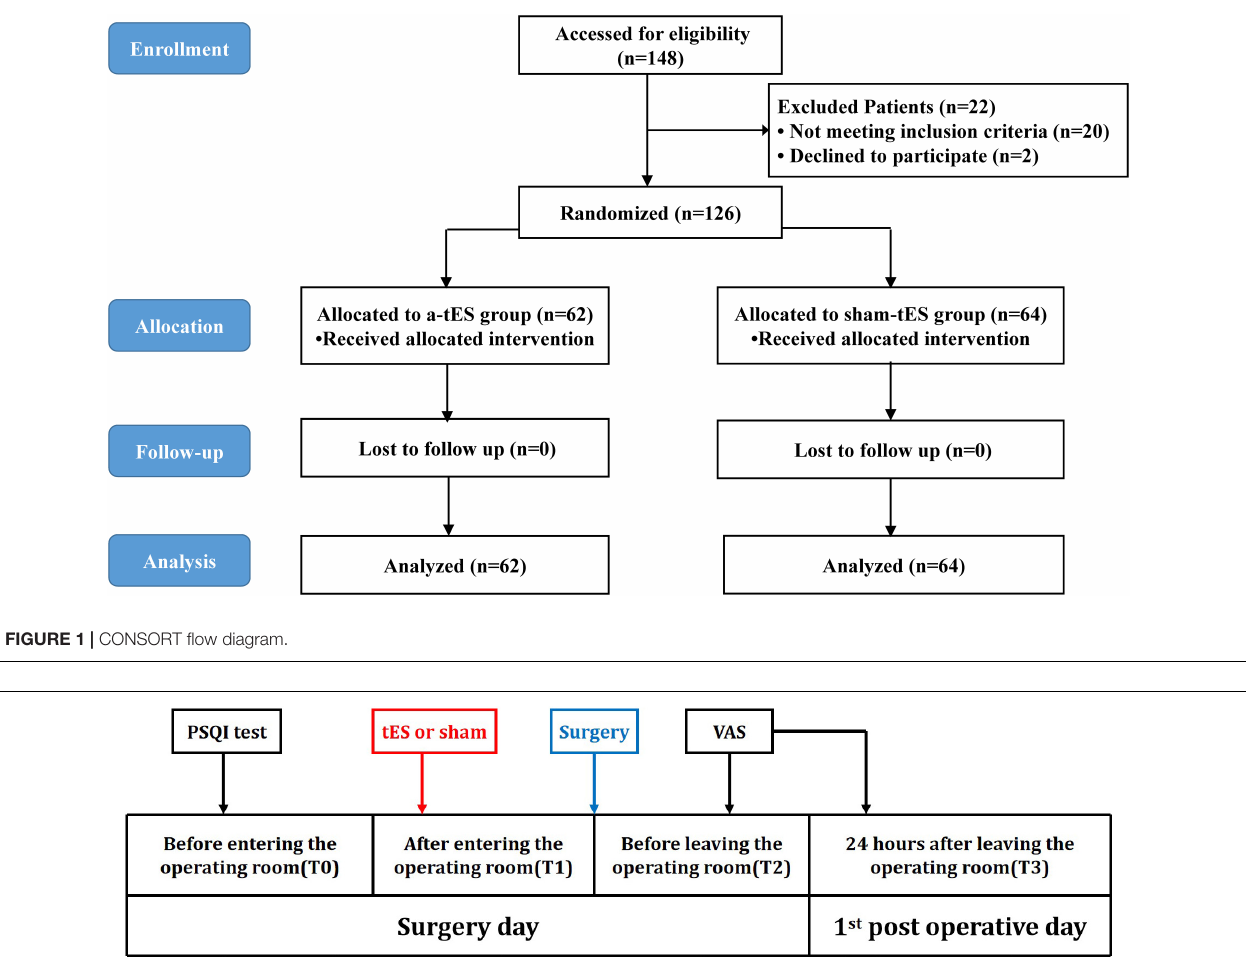
FIGURE 2 | Timeline of experimental design. Experimental design and timeline of the two experimental sessions (active-tES and